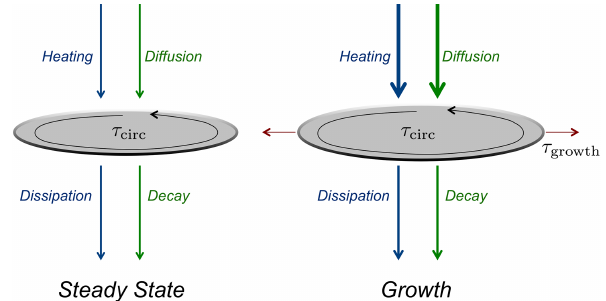
Figure 2. Thermodynamic representation of an open system. Re- versible circulations within a system that lies along a constant po- tential have a characteristic time τ circ . Circulations are sustained by a dissipation of a potential energy source that heats the system. The system maintains a steady state (left panel) because energetic (blue) and material (green) flows enter and leave the system at the same rate. Where there is a positive imbalance (right panel), the system grows irreversibly with timescale τ growth (cid:29) τ circ . See Appendix A for